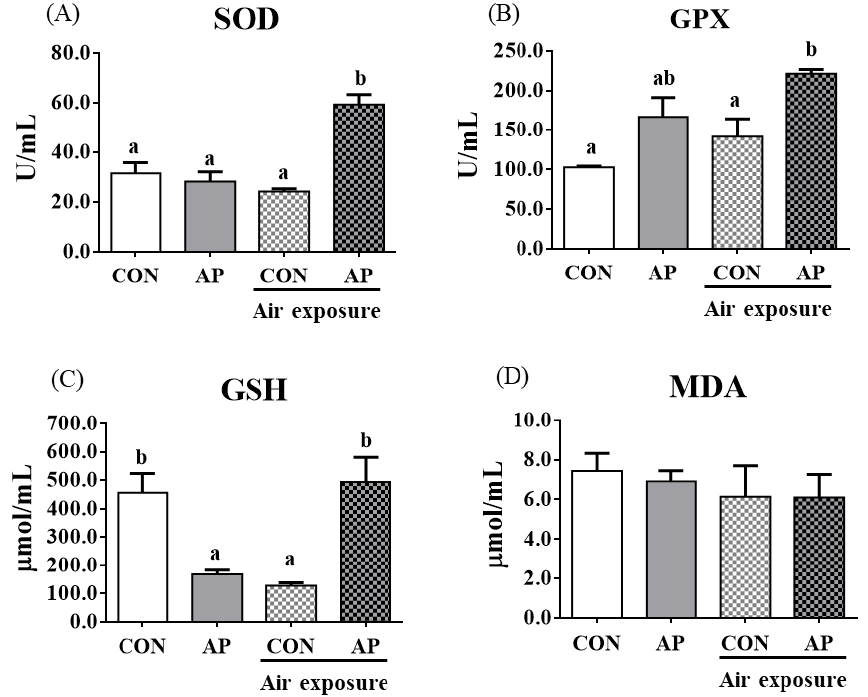
Figure 2. Plasma antioxidant related parameters in the two groups before and after air exposure stress. SOD ( A ), GPX ( B ), GSH ( C ), and MDA ( D ). Values are represented as the mean ± SEM ( n = 6). Bars with different lowercase letters mean significant differences among groups ( p < 0.05).